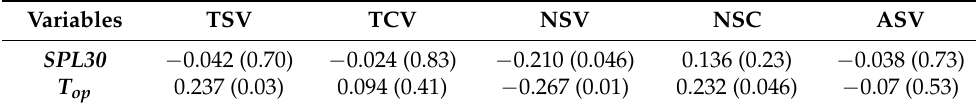
Table 6. Kendall’s correlation results ( τ b (p)) for two monitored IEQ